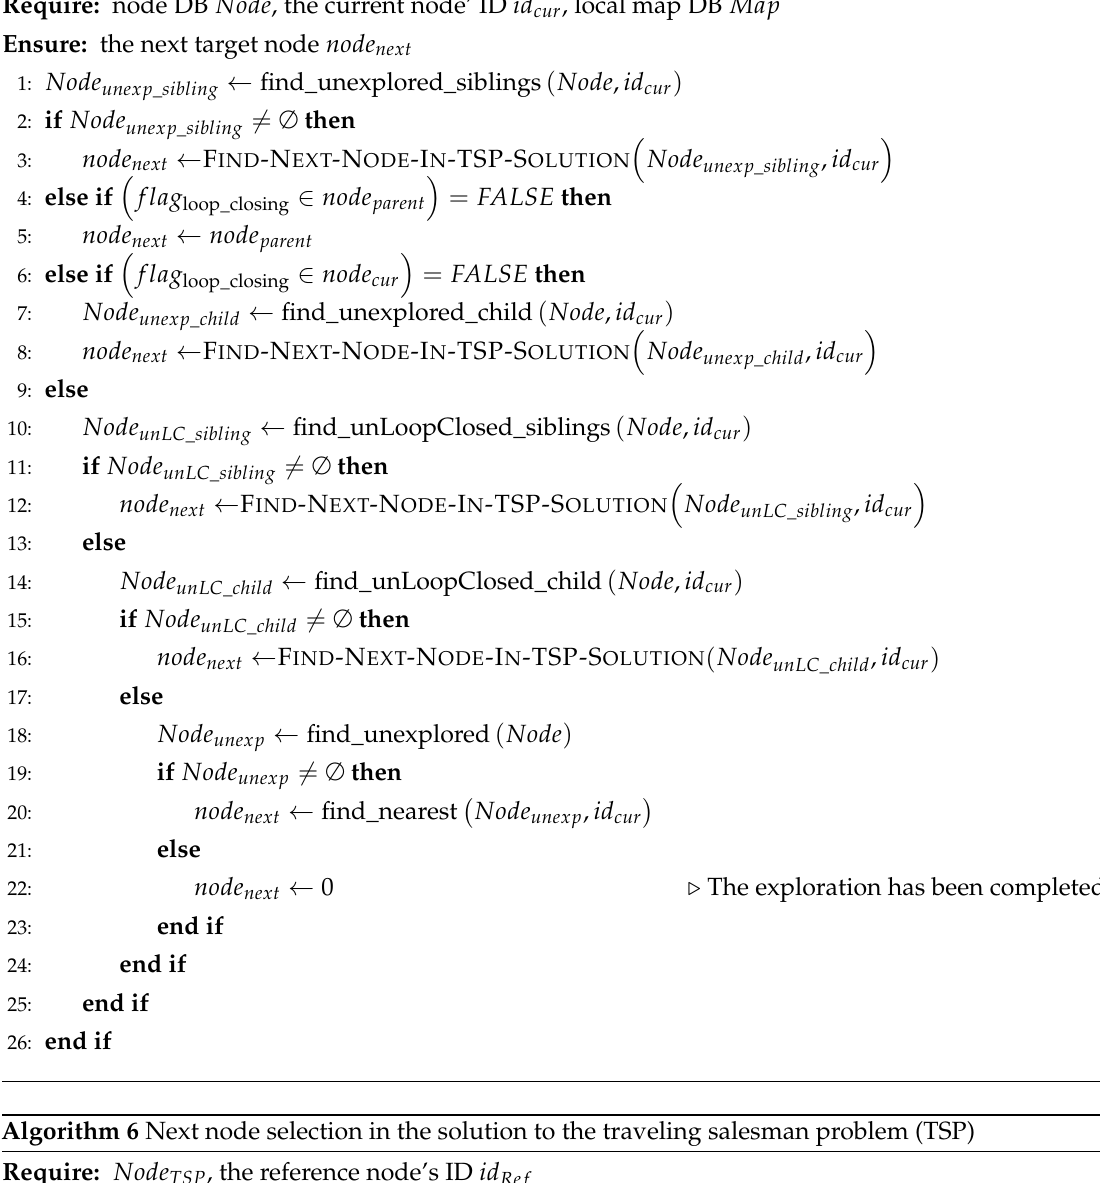
Algorithm 5 Breadth-first search (BFS) exploration to decide the next target node